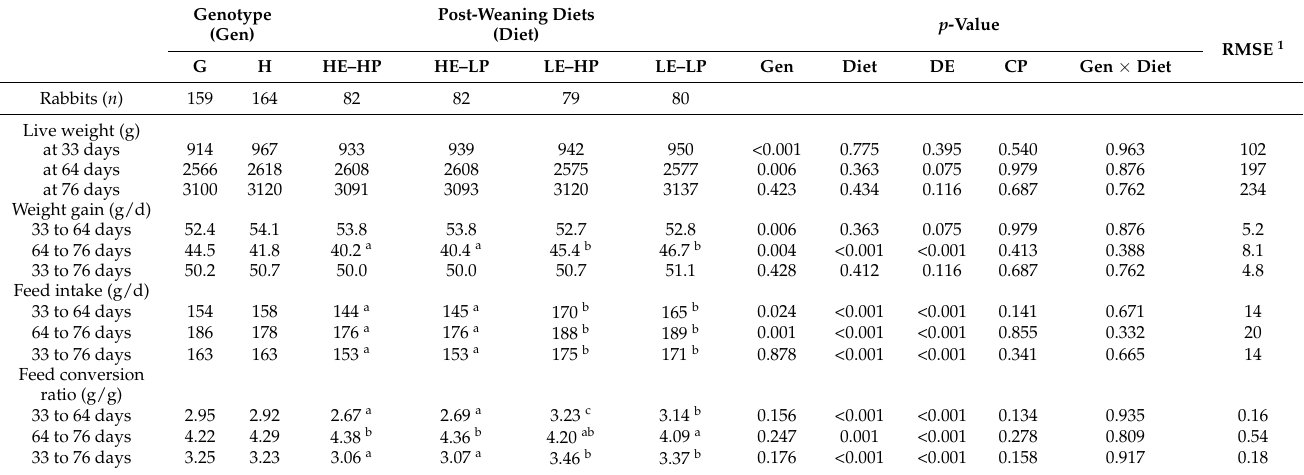
Table 2. Growth performance of rabbits from 33 to 76 days of